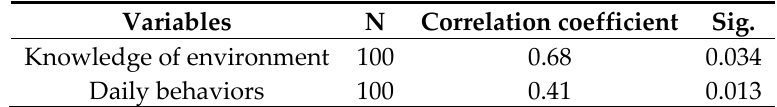
Table 5. Correlation analysis between Public awareness among Knowledge of environment and Daily